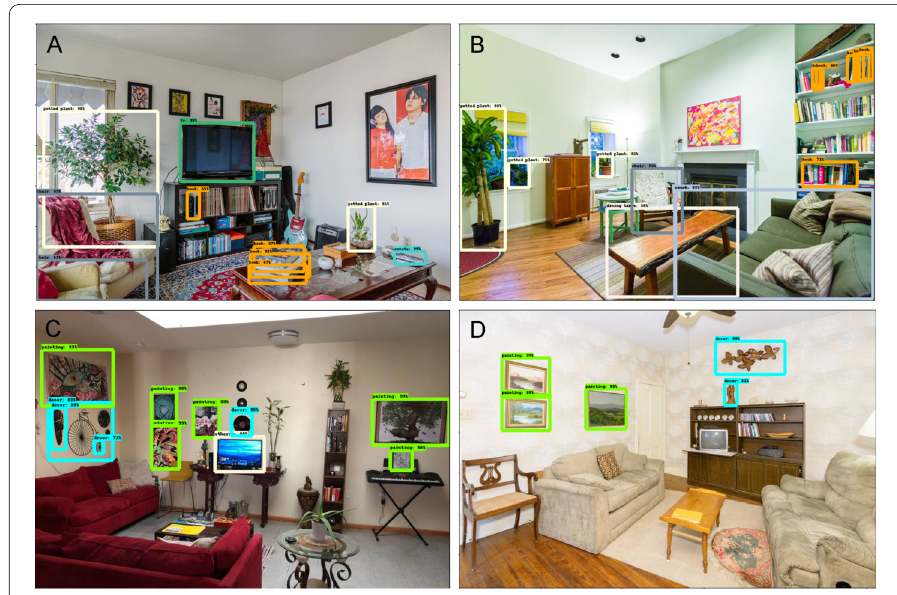
Figure 2 Object detection. Object detection examples for living room images. Ivory and orange bounding boxes in ( a ) and ( b ) are the model’s results for plant and book identification, respectively. Green and blue bounding boxes in ( c ) and ( d ) are the model results for wall art and decor identification, respectively